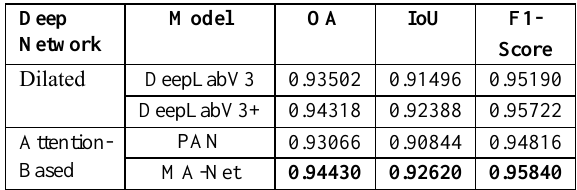
Table 2 . Comparison of DeepLabV3, DeepLabV3+, PAN